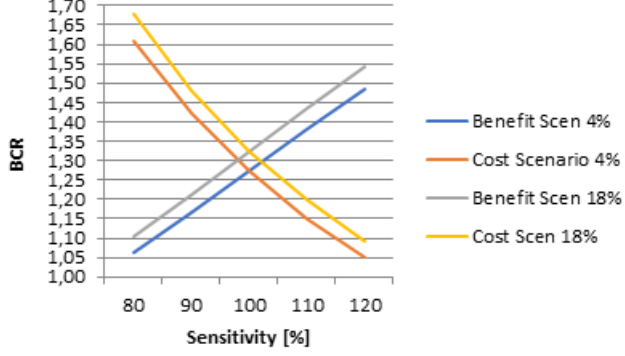
Figure 6: Graph sensitivity of B, C to BCR in scenario 4% and